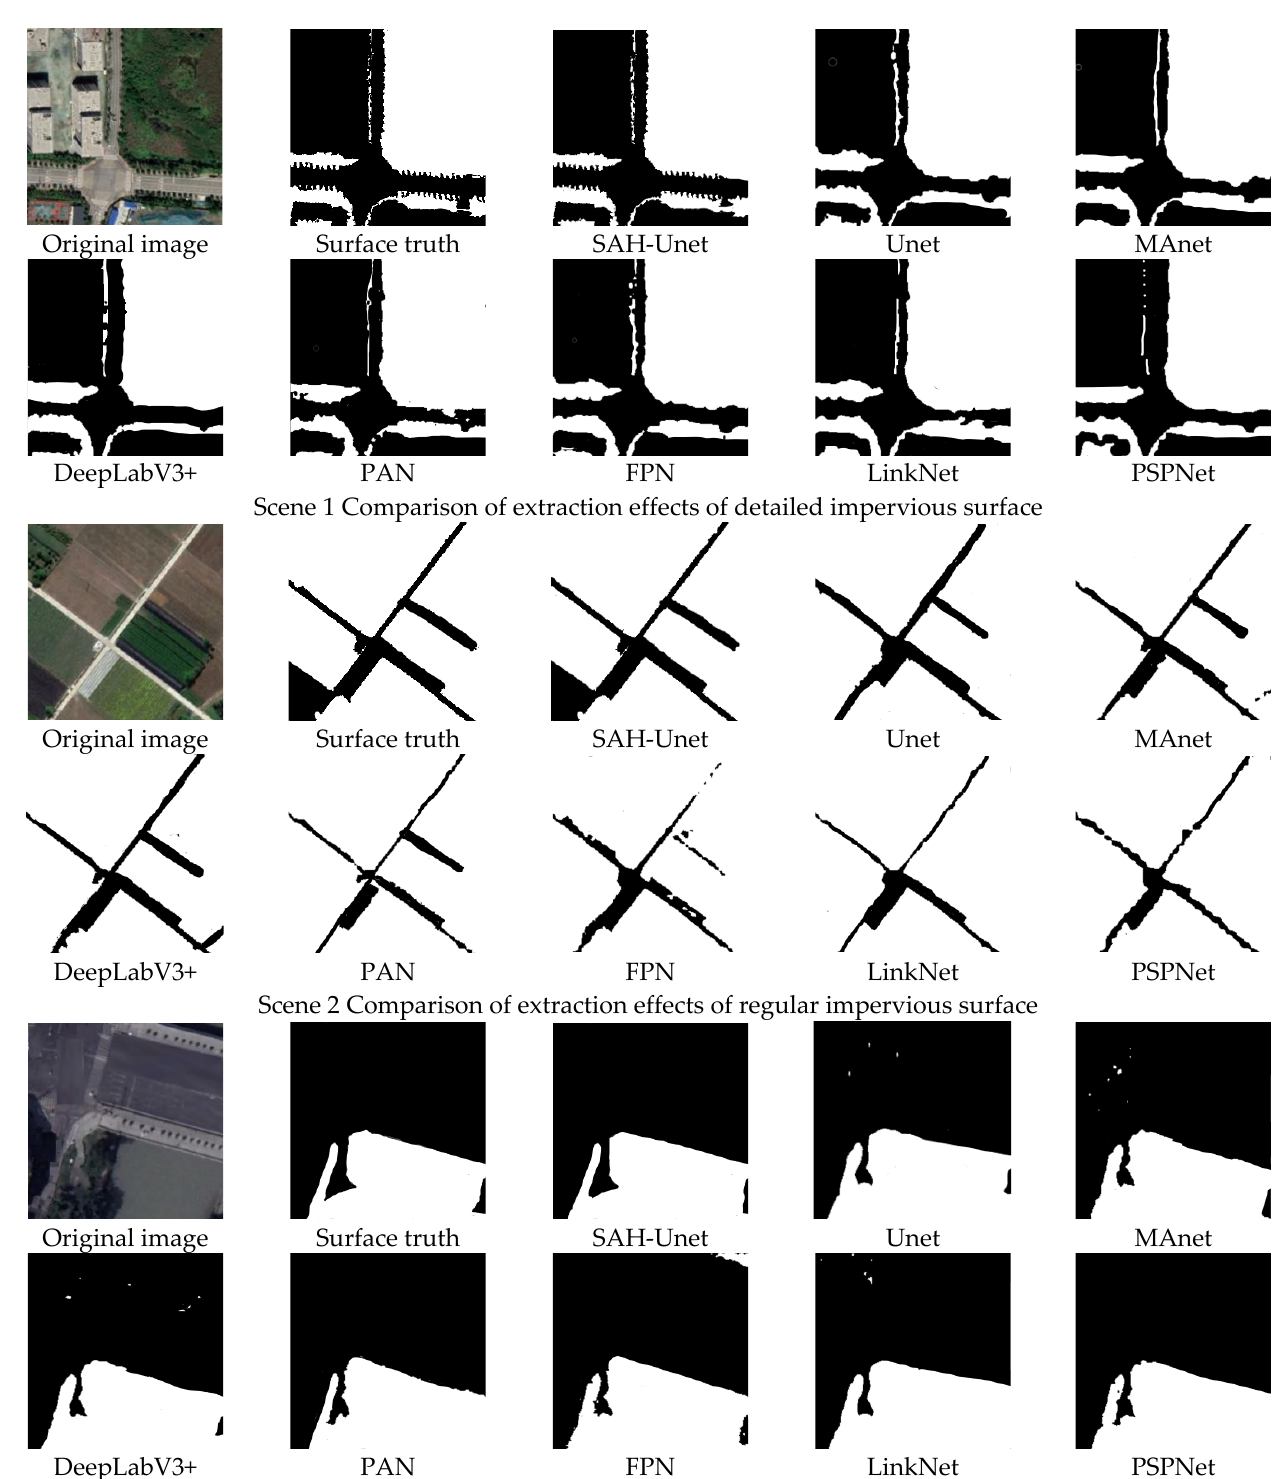
Figure 9. Results of impervious surface extraction by different methods.